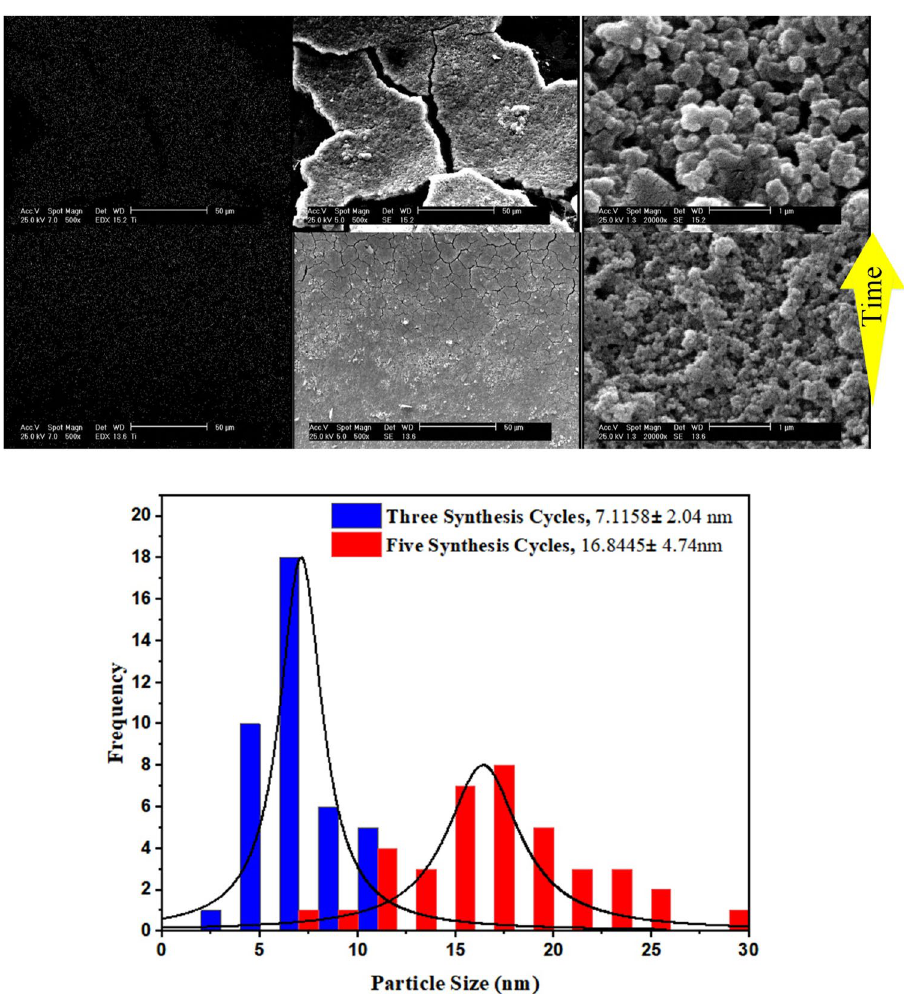
Figure 5. The impact of synthesis time on the microchannel surface coverage and size of TiO 2 .